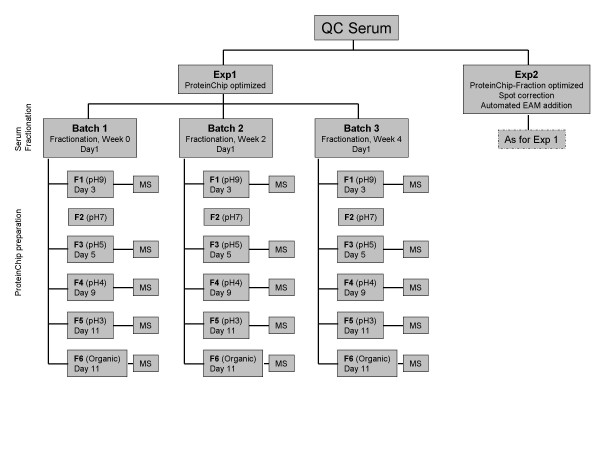
Outline of the experimental workflow for SELDI-TOF optimization. QC serum was fractionated and run as 6 replicates of fractions F1, F3, F4, and F6 on IMAC, CM10 LS and H50 ProteinChips; as 6 replicates of F3 and F4 on CM10 HS and 6 replicates of F5 on CM10 LS ProteinChips.